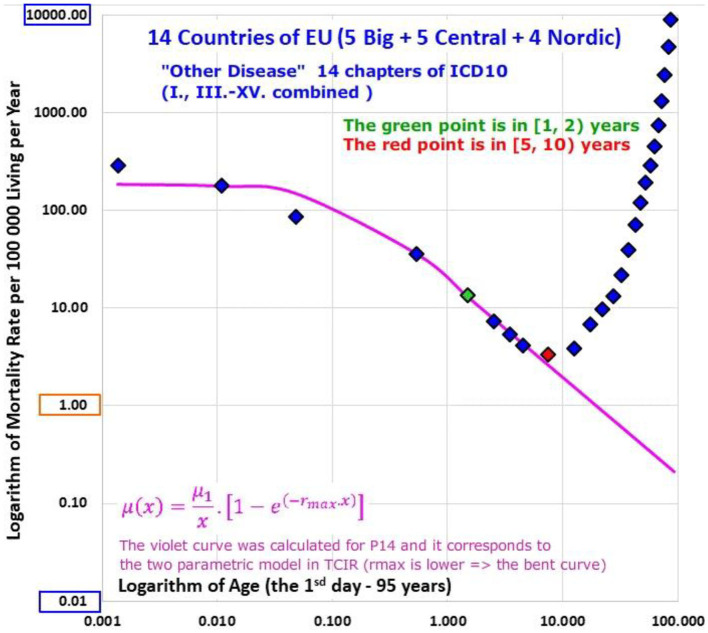
(Animation 5) Other diseases in P14.